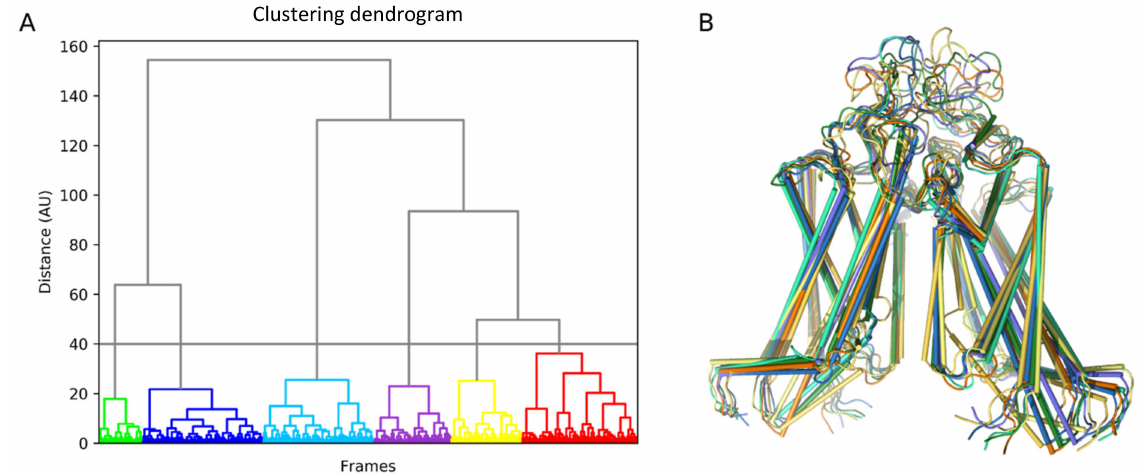
Figure 9. Clustering of ABCG2 conformations obtained in the molecular dynamics (MD) simulation. ( A ) Ttclust output for clustering results in the form of a dendrogram. ( B ) Corresponding cluster representative for the six conformers further used for ruxolitinib